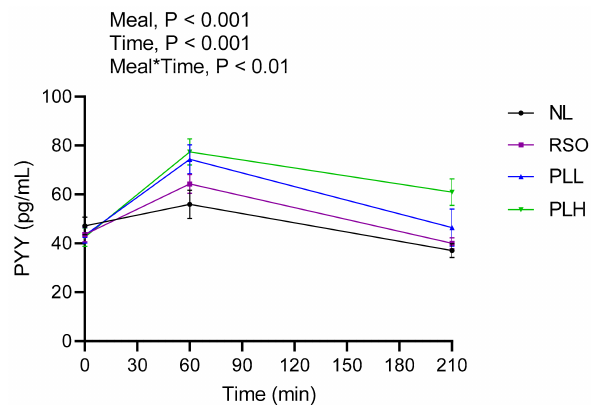
Figure 8. Mean concentration of PYY after the breakfast meal. Values are means ± SEM, n = 20 healthy subjects. Repeated measures; mixed model in SAS. NL, oat preparation without added lipids; RSO, oat preparation added with rapeseed oil; PLL, oat preparation with a low concentration of polar lipids; PLH, oat preparation with a high concentration of polar lipids.